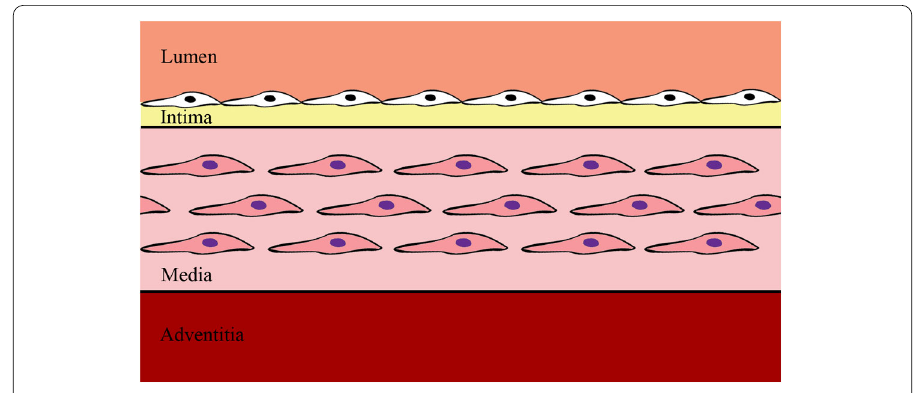
Figure 1 Diagram showing different layers of the arterial